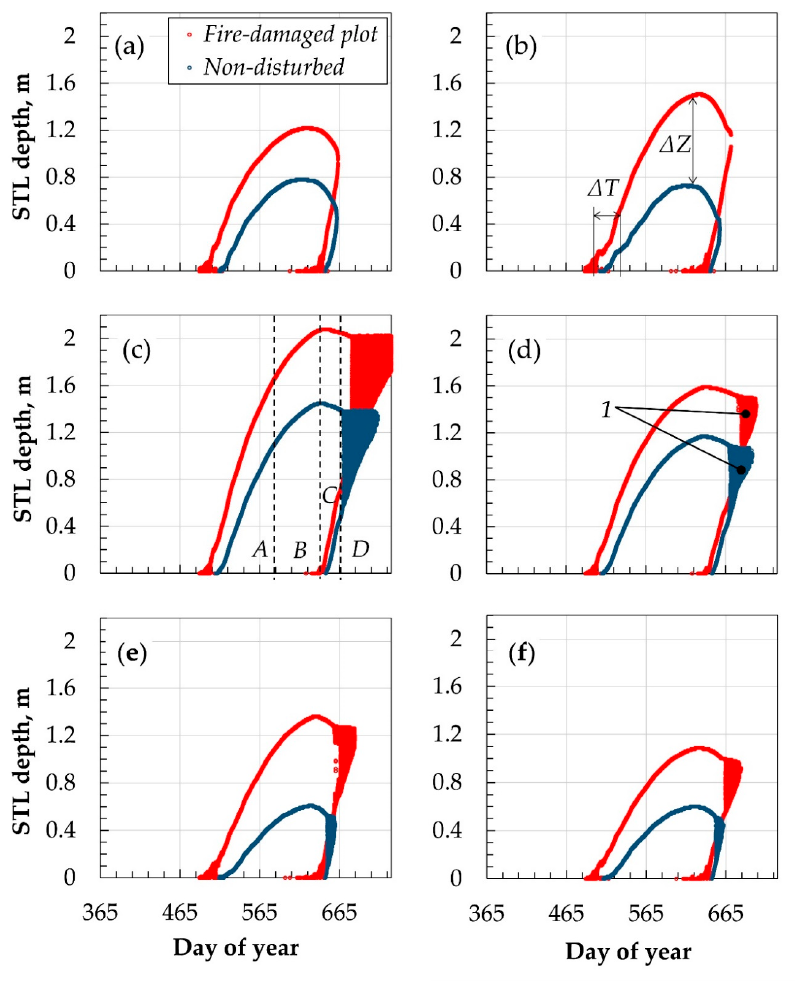
Figure 5. The results of numerical simulations of STL thickness under two extreme cases of initial conditions of soil, and conditions for the soil with non-homogenous water content: ( a ) Dry soil (Qw = 0.1 · Q) in the model developed by Ekici et al. (2014) [51]; ( b ) Dry soil in the model built by Pavlov (2008) [45]; ( c ) Water-saturated soil (Qw = 0.9 · Q, Qw not di ff erentiated for soil horizons) and model developed by Ekici et al. (2014) [51]; ( d ) Water-saturated soil in the model built by Pavlov (2008) [45]; ( e ) Soil with non-homogenous water content in the model developed by Ekici et al. (2014) [51]; ( f ) Soil with non-homogenous water content in the model built by Pavlov (2008) [45]. Results are from a model for the 365th day of the year, as the first 365 countings were used for system debugging and